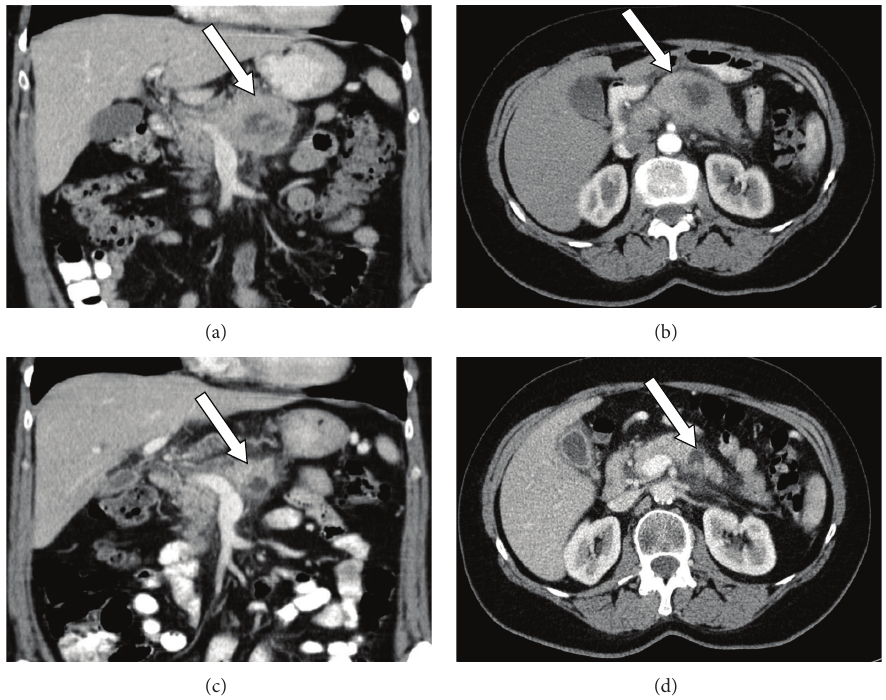
Figure 2: CT scans of the index patient. (a) (transversal image) and (b) (horizontal image) show the tumor’s pretreatment extension with centrally cystic areas and signs of splenic vein infiltration; (c) (transversal image) and (d) (horizontal image) show tumor shrinkage after neoadjuvant radiochemotherapy; arrow is directed to tumor